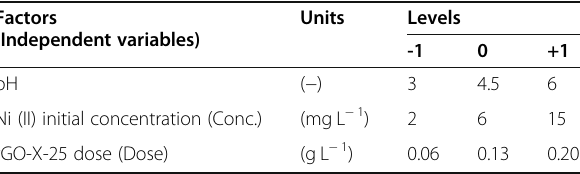
Units Levels -1 0 +1